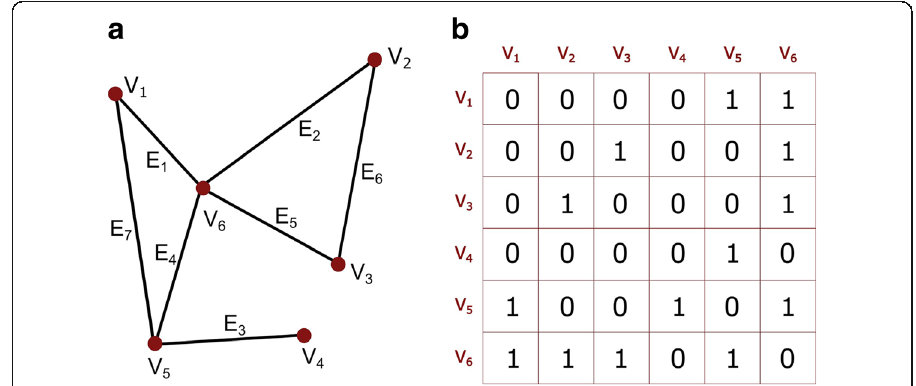
Fig. 1 a An example of undirected and unweighted graph G = (V, E), where V is the set of nodes and E is the set of edges. b The binary adjacency matrix corresponding to the graph, where zeros and ones respectively represent the absence or presence of an edge between a pair of